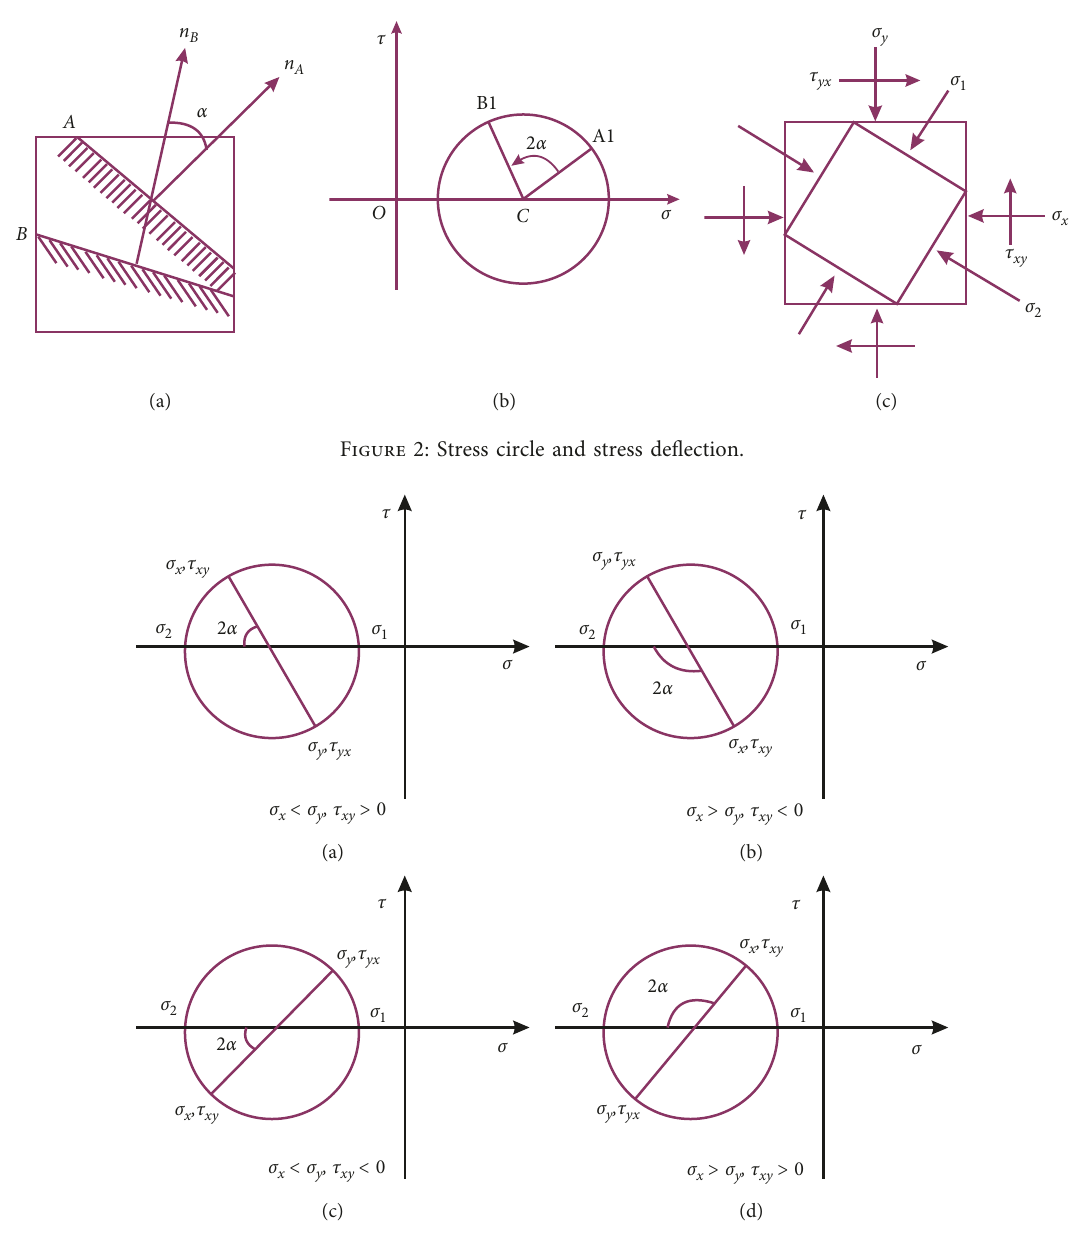
Figure 3: Deflection angle with different stress states. (a) σ